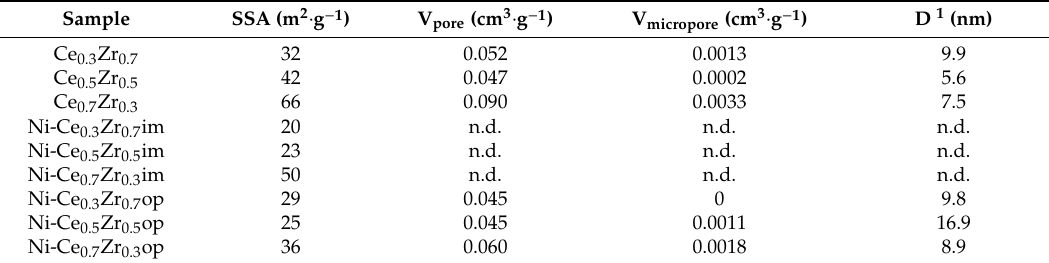
Table 1. Textural characteristics of the Ce x Zr 1 − x O 2 and Ni-containing catalysts.